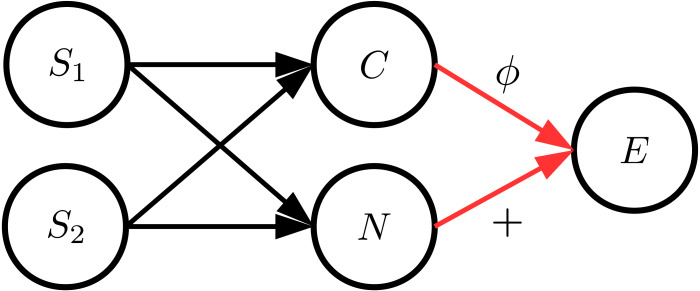
The general structure of the data generation process where C and N are dependent.In order to achieve this, cause and noise consist of a mixture of two sources S1 and S2.